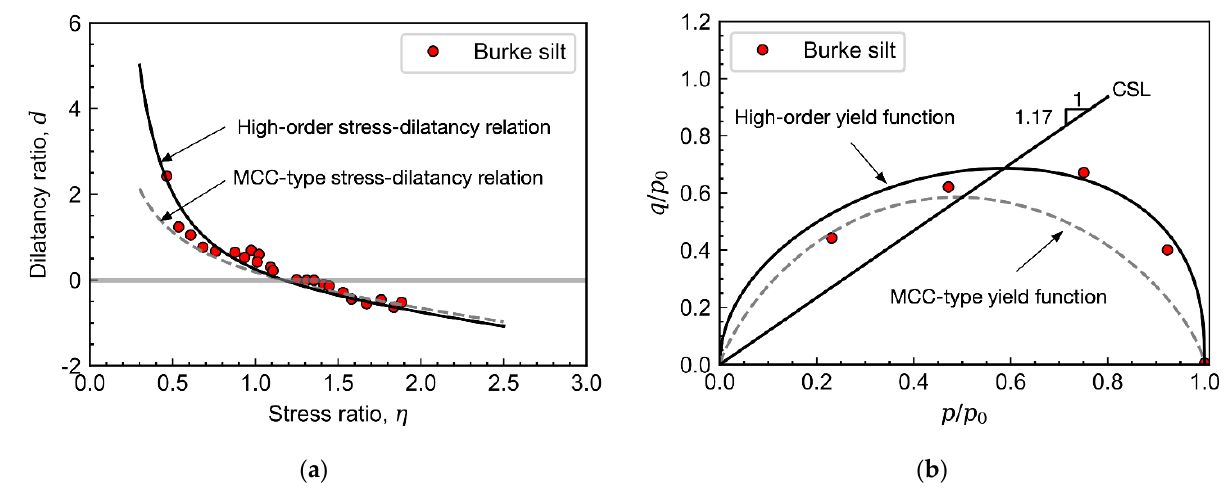
Figure 2. The performance of the proposed stress–dilatancy relation and the yield function: ( a ) the stress–dilatancy relation; ( b ) the yield function.